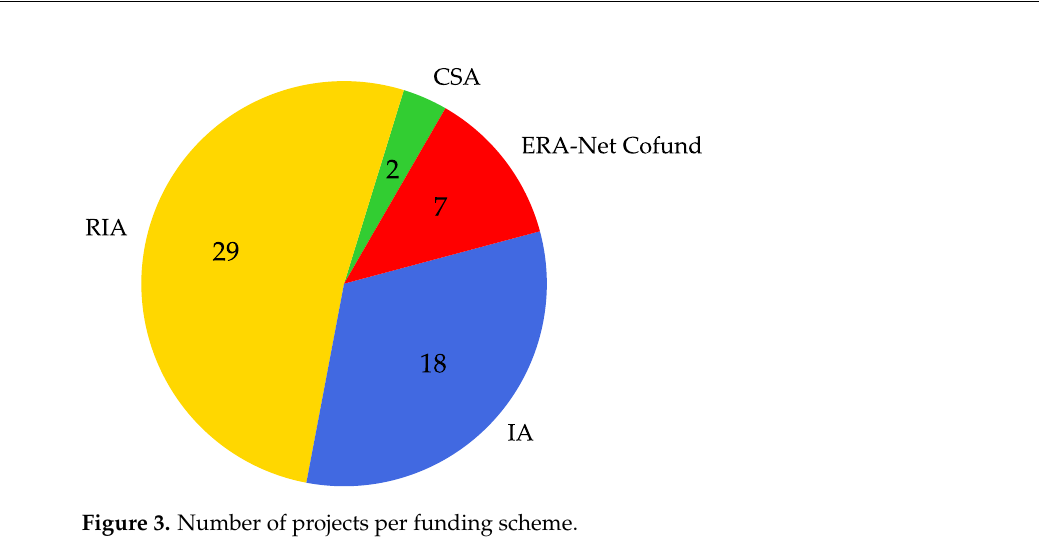
Figure 3. Number of projects per funding scheme.